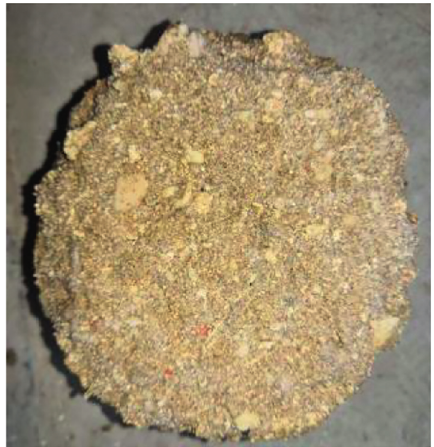
Figure 10: The sample after